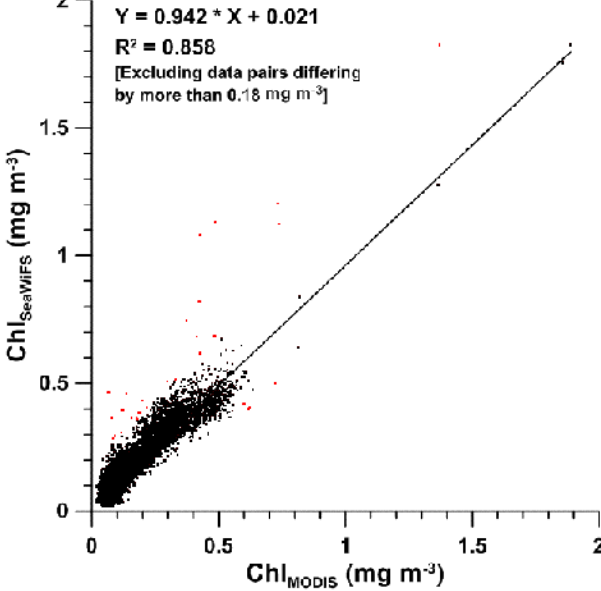
Fig. 4. Correlation between the pairs of Chl data observed by SeaWiFS and by MODIS for the same pixels on the same day (See text). Data pairs (shown in red) that differ by more than 0.18mgm − 3 (5 times the rms of all deviations) are excluded for the regression